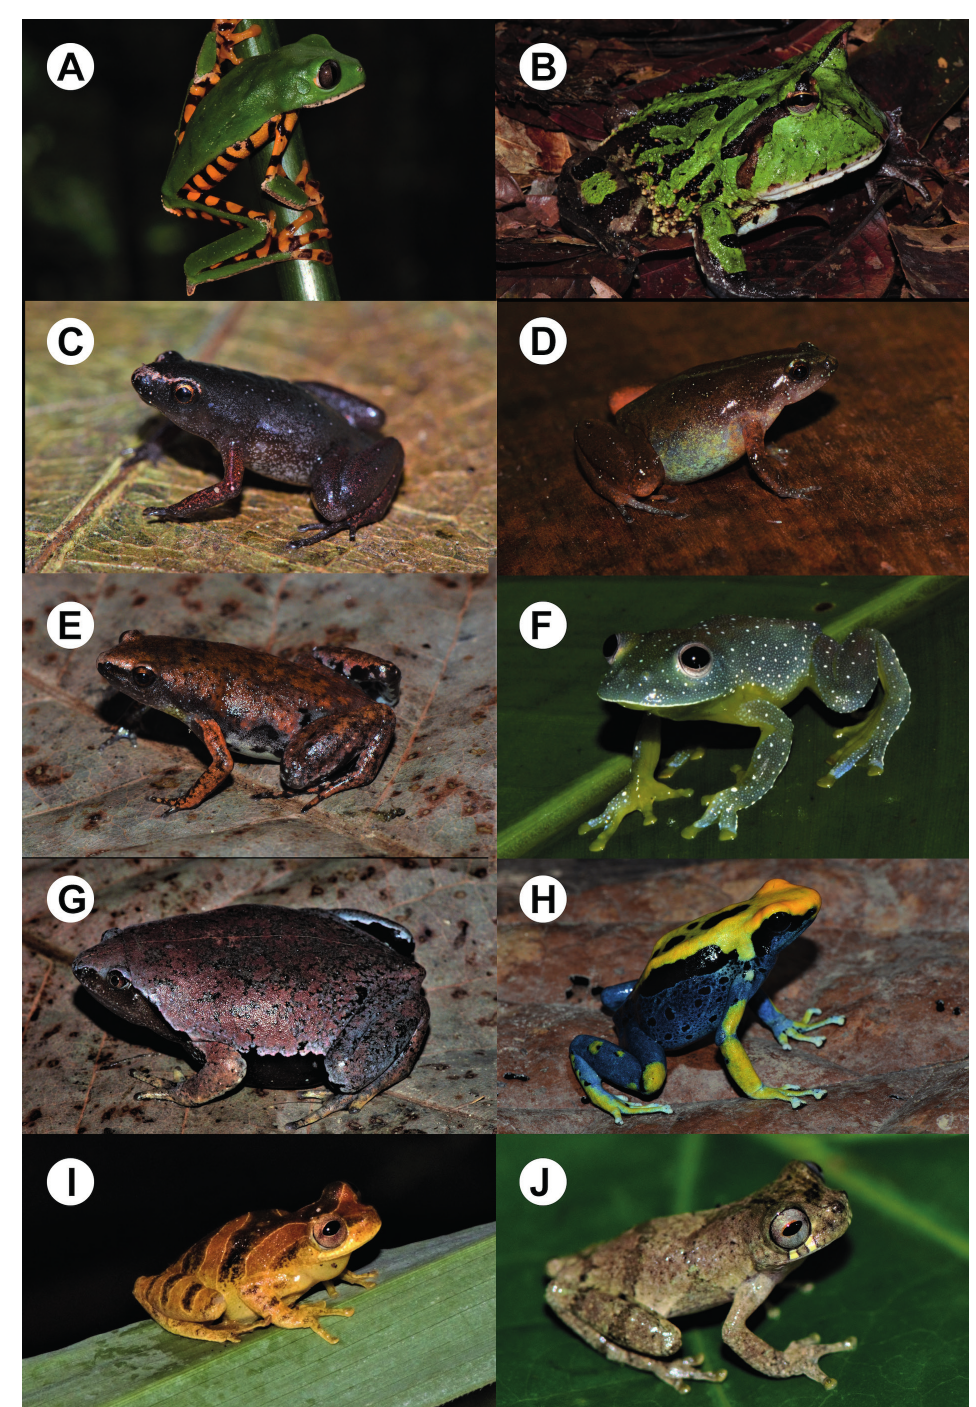
Fig. 3. Anuran species recorded in the state of Amapá. A . Callimedusa tomopterna (Cope, 1868). B . Ceratophrys cornuta (Linnaeus, 1758). C . Chiasmocleis haddadi Peloso, Sturaro, Forlani,